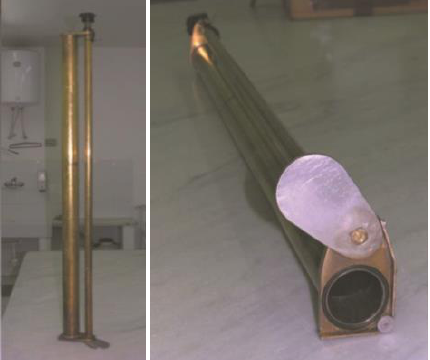
Figure 3. View of the sampler (modified from [24]).